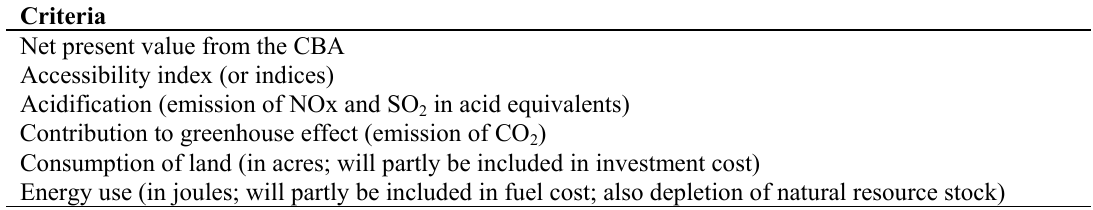
Table 2. Criteria in MCA1